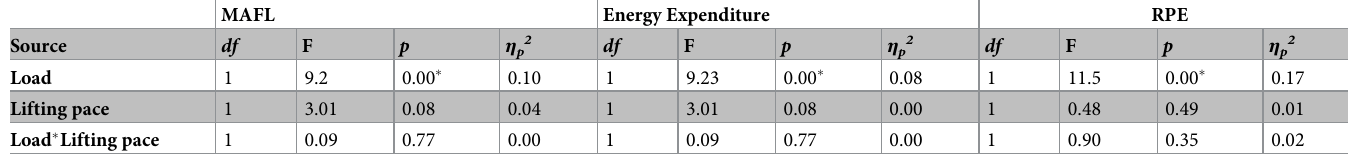
Table 3. Analysis of variance for the maximum acceptable frequency limit, energy expenditure and rating of perceived exertion. MAFL Energy Expenditure RPE Source Lifting